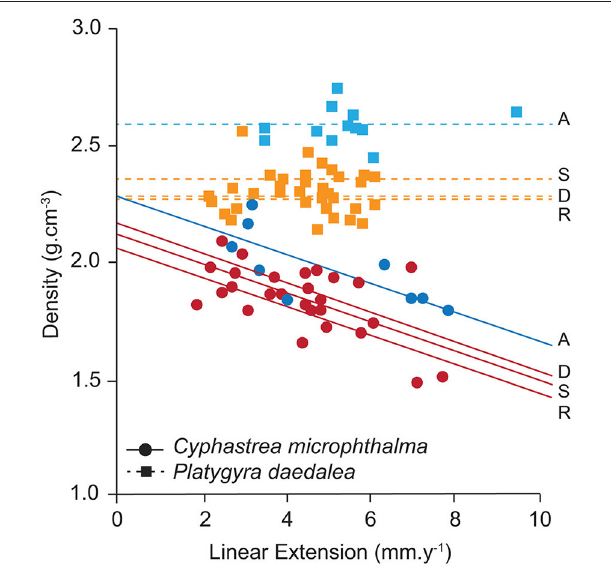
FIGURE 4 | Site variation in density and its relationship to linear extension for the corals Cyphastrea microphthalma and Platygyra daedalea in the Persian Gulf (red/orange) and Oman Sea (dark blue/light blue). Values are means of colonies (symbols) and sites (lines) from model outputs and raw